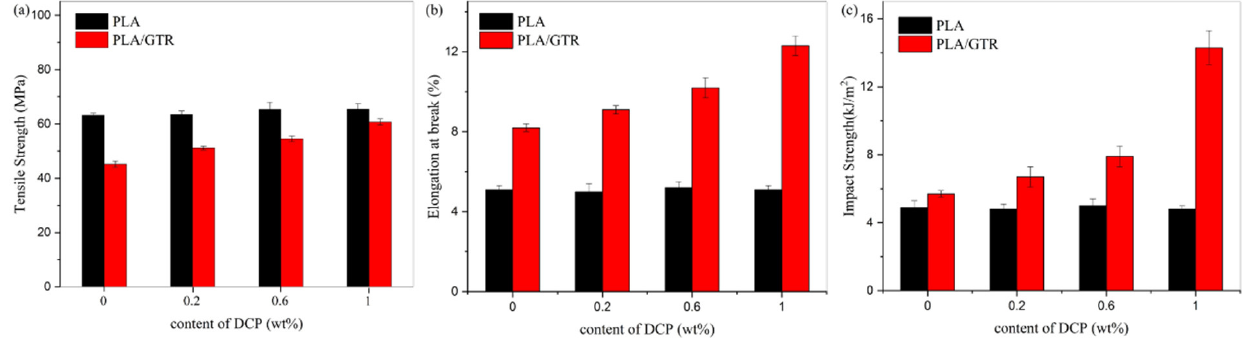
Figure 5. Mechanical properties of neat PLA and PLA/GTR (95/5) as a function of DCP content: ( a ) Tensile strength. ( b ) Elongation at break. ( c ) Notched Izod impact